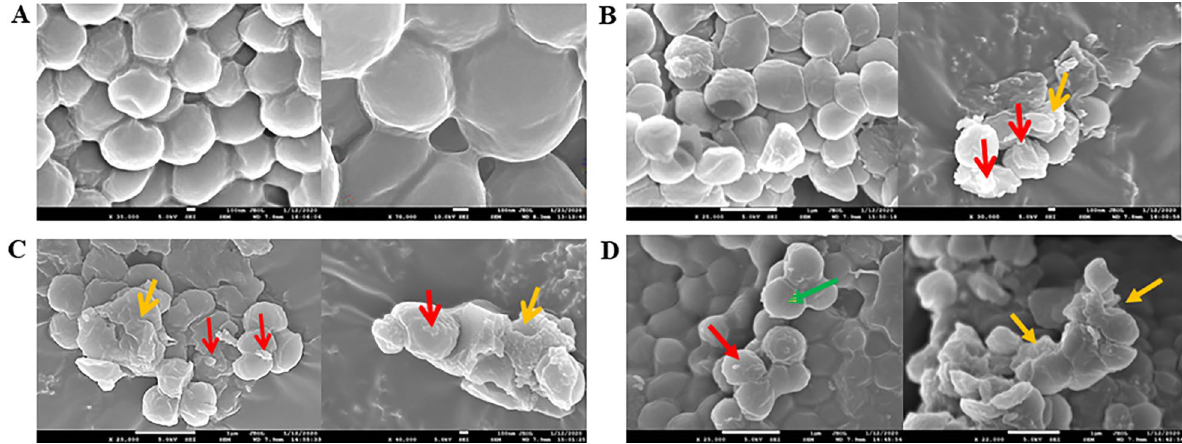
Figure 5. Electron microscopy of surface morphological changes of bacteria triggered by homicorcin and its variant homicorcin 1. Electron micrographs showing membrane morphology of Micrococcus luteus ATCC 1856 under the following conditions: ( A ) without treatment, ( B ) nisin A-treated and ( C ) homicorcin and ( D ) homicorcin 1 treated. {Normal cell ( green arrow ); Pore on cell membrane ( red arrow ); Lysed cell with deformed cell membrane ( orange arrow